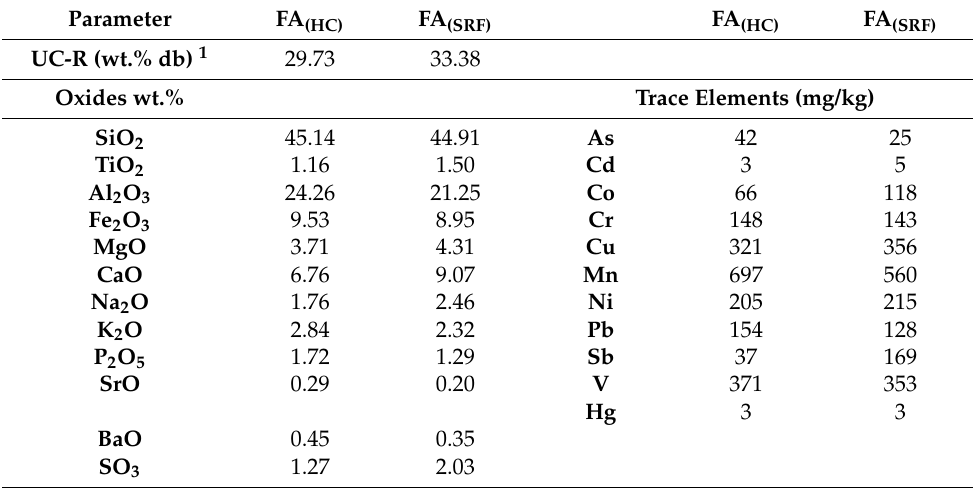
Table 2. Geochemical data of the studied fly ashes